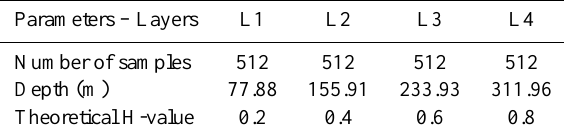
Table 1. Simulated four-layer geological model parameters.